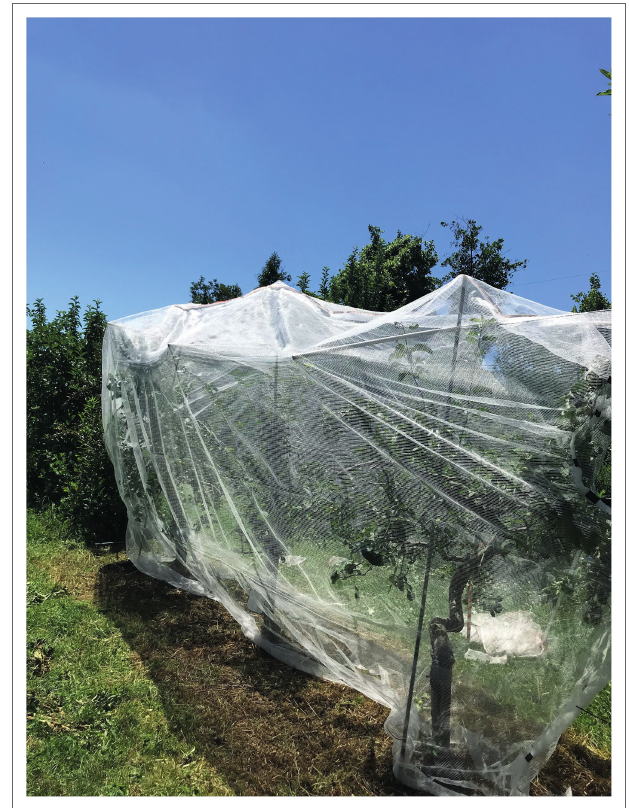
FIGURE 5 | Netted BpMADS4 transgenic apple trees used for crosses in the experimental orchard at Cornell University. Nets around the trees prevent pollinators from spreading the transgenic pollen outside the orchard. Source: Dr. Awais Khan who leads the rapid cycle breeding program at Cornell University in Geneva (New York, United States) kindly provided the